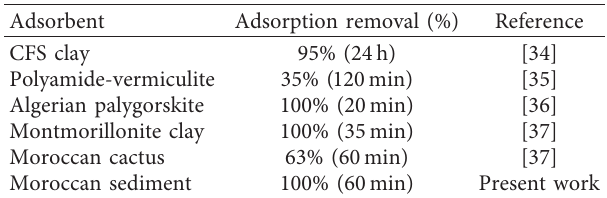
Table 4: Comparison of the adsorption efficiency of methylene blue on various literature